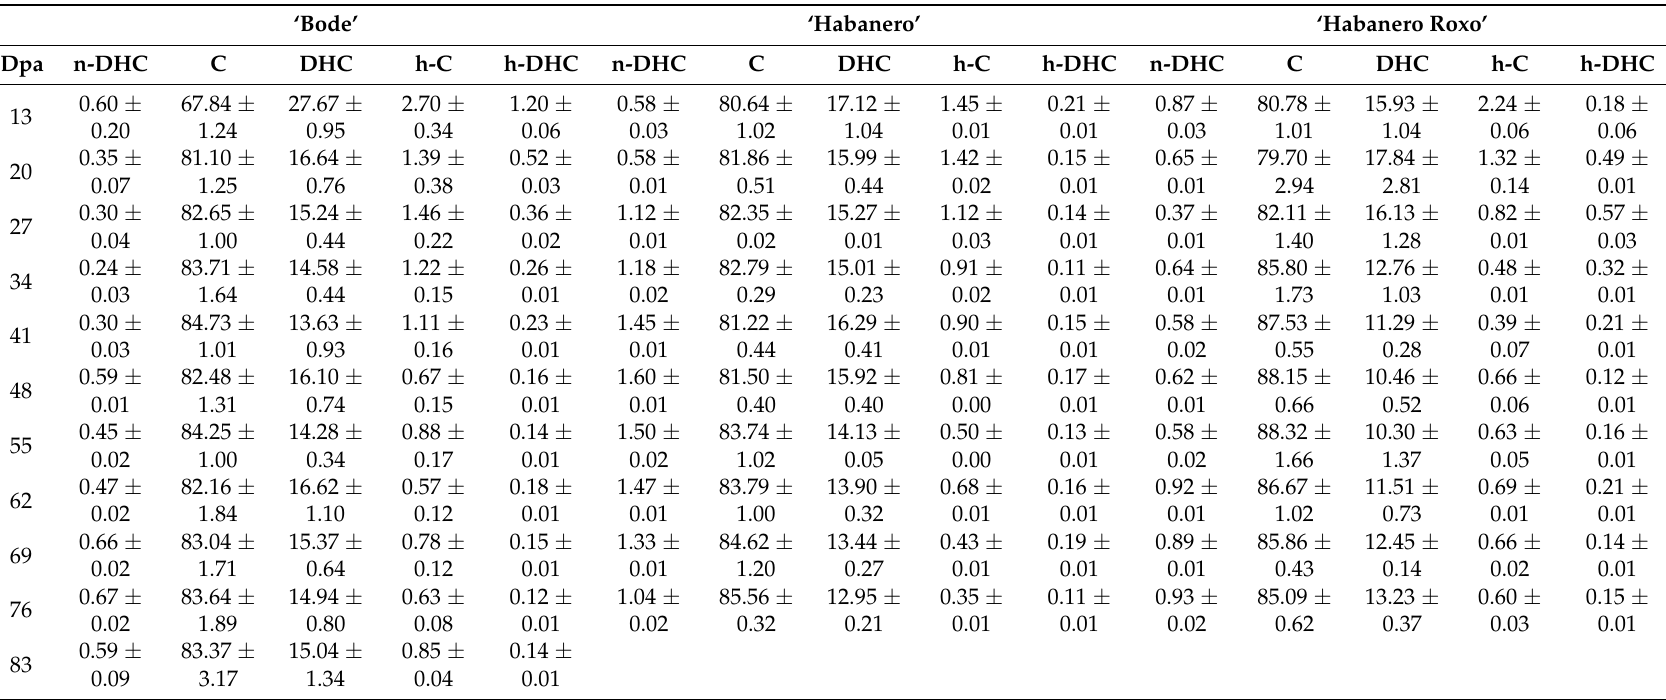
Relative percentages of individual capsaicinoids (nordihydrocapsaicin (n-DHC), capsaicin (C), dihydrocapsaicin (DHC), homocapsaicin (h-C), and homodihydrocapsaicin h-DHC)) in Capsicum chinense cultivars during pepper fruit ripening. Results are presented as mean ± SD ( n = 3). Different letters in the same column indicate statistically significant differences between groups ( p < 0.05). The development stages of pepper fruits were measured as days post-anthesis